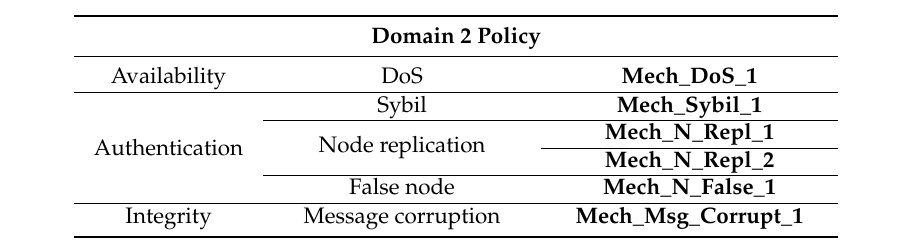
Table 9. Trust domain 2